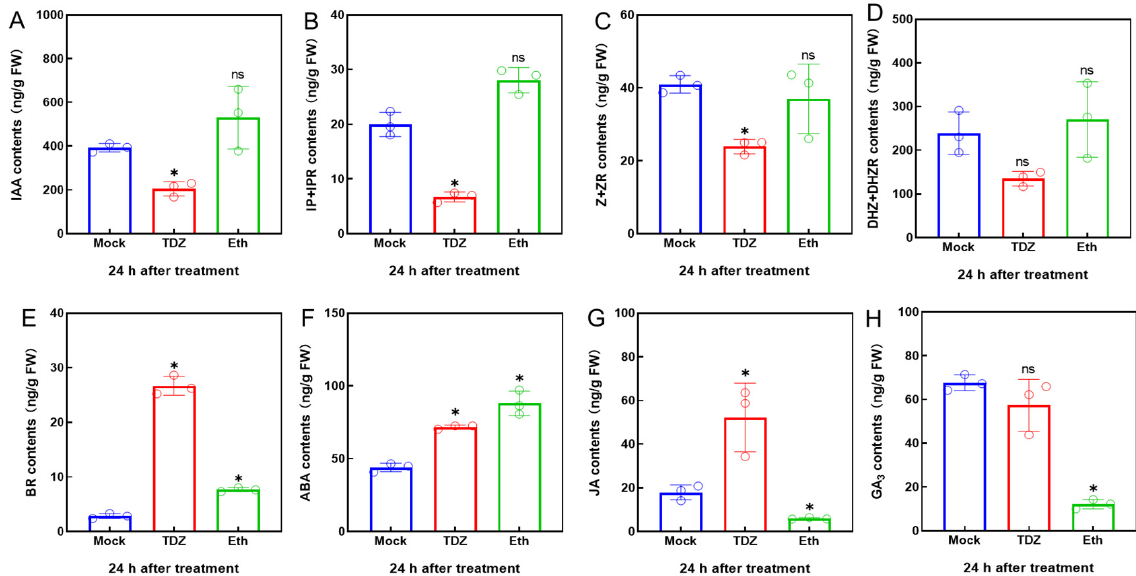
Figure 2. The content of auxin (IAA, ( A )), isopentenyl adenine and isopentenyl adenosine (IP+IPR, ( B )), zeatin and zeatin riboside (Z+ZR, ( C )), dihydrozeatin and dihydrozeatin riboside (DHZ+DHZR, ( D )), brassinosteroid (BR, ( E )), abscisic acid (ABA, ( F )), jasmonic acid (JA, ( G )), and gibberellin (GA 3 , ( H )) in the fourth leaf (from bottom) of cotton plants at 24 h after treatment with 300 mg/L thidiazuron (TDZ) or 0.6 mg/L ethephon (Eth). Mock: water. Significant differences between TDZ or Eth and Mock were determined by t -test, * indicates p -value < 0.05, ns indicates no signi fi cant di ff erence.